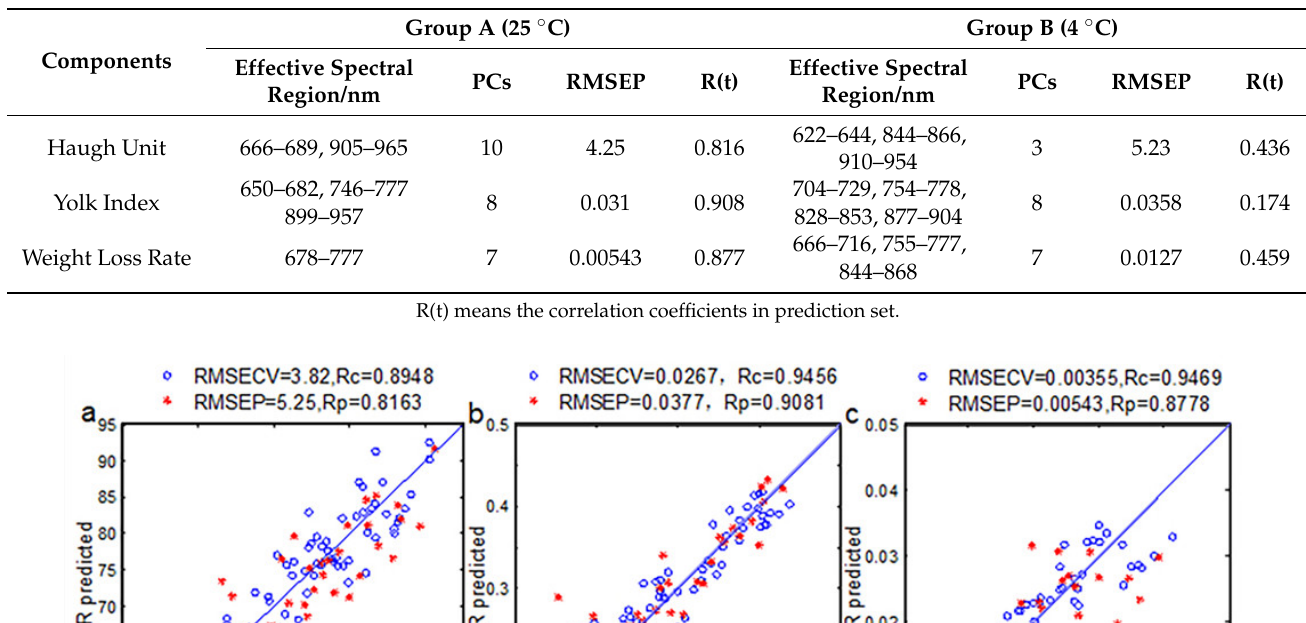
Figure 5. Optimal spectral regions selected by SI-PLS of the Haugh Unit ( a ), yolk index ( b ), weight loss rate ( c ) in egg samples. 4. Conclusions In this work, the freshness of eggs stored at room and refrigerated temperatures was investigated. The indicators of Haugh unit, yolk index, and weight loss express egg storage time at room temperature conditions. In contrast, only weight loss could excellently express egg storage time in refrigerated storage conditions. NIR spectroscopy